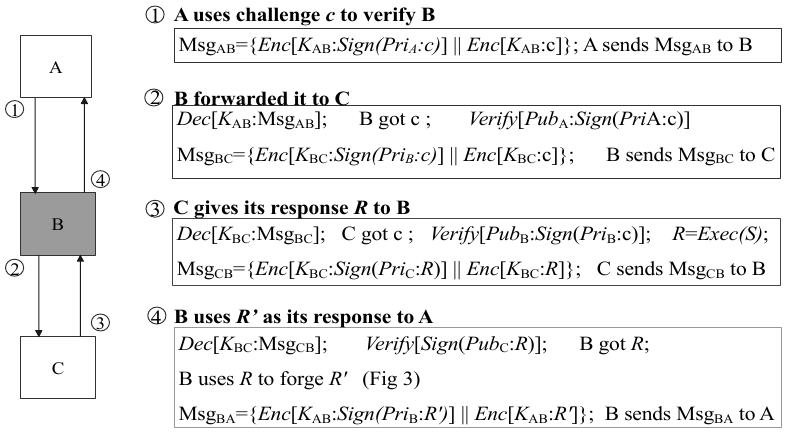
Figure 2. The response defraud in decentralized CFA